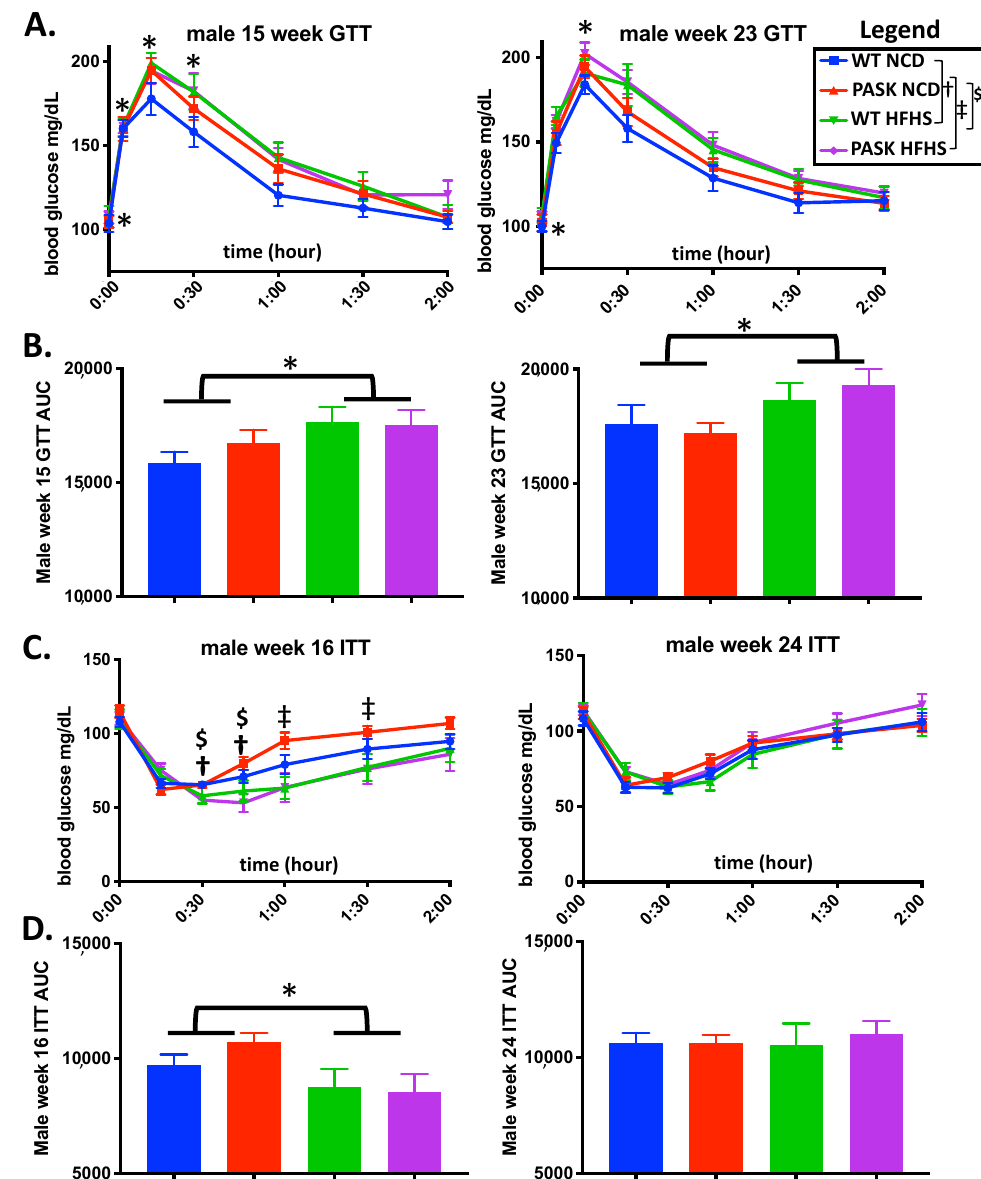
Figure 2. The HFHS diet effects both GTT and ITT response. ( A ) Blood glucose levels during IP glucose tolerance testing (GTT) at 15 weeks and 23 weeks on the HFHS diet. ( B ) Area under the curve (AUC) from ( A ). ( C ) Blood glucose levels during IP insulin tolerance testing (ITT) at 16 weeks and 24 weeks on the HFHS diet. ( D ) Area under the curve (AUC) for ( C ). All data were analyzed by factorial ANOVA in JMP Pro version 14 with post hoc Tukey HSD analysis to investigate interactions between diet and genotype and post hoc Dunnett’s analysis for either diet and genotype separately when no interaction is seen. P -values less than or equal to 0.065 are shown (WT-NCD compared with WT-HFHS † , NCD compared with PASK-HFHS ‡ , NCD compared with WT-HFHS $ and * indicates differences due to diet, namely, all mice on NCD versus all mice on HFHS diet). A corresponding legend is provided in the top right. All groups n =